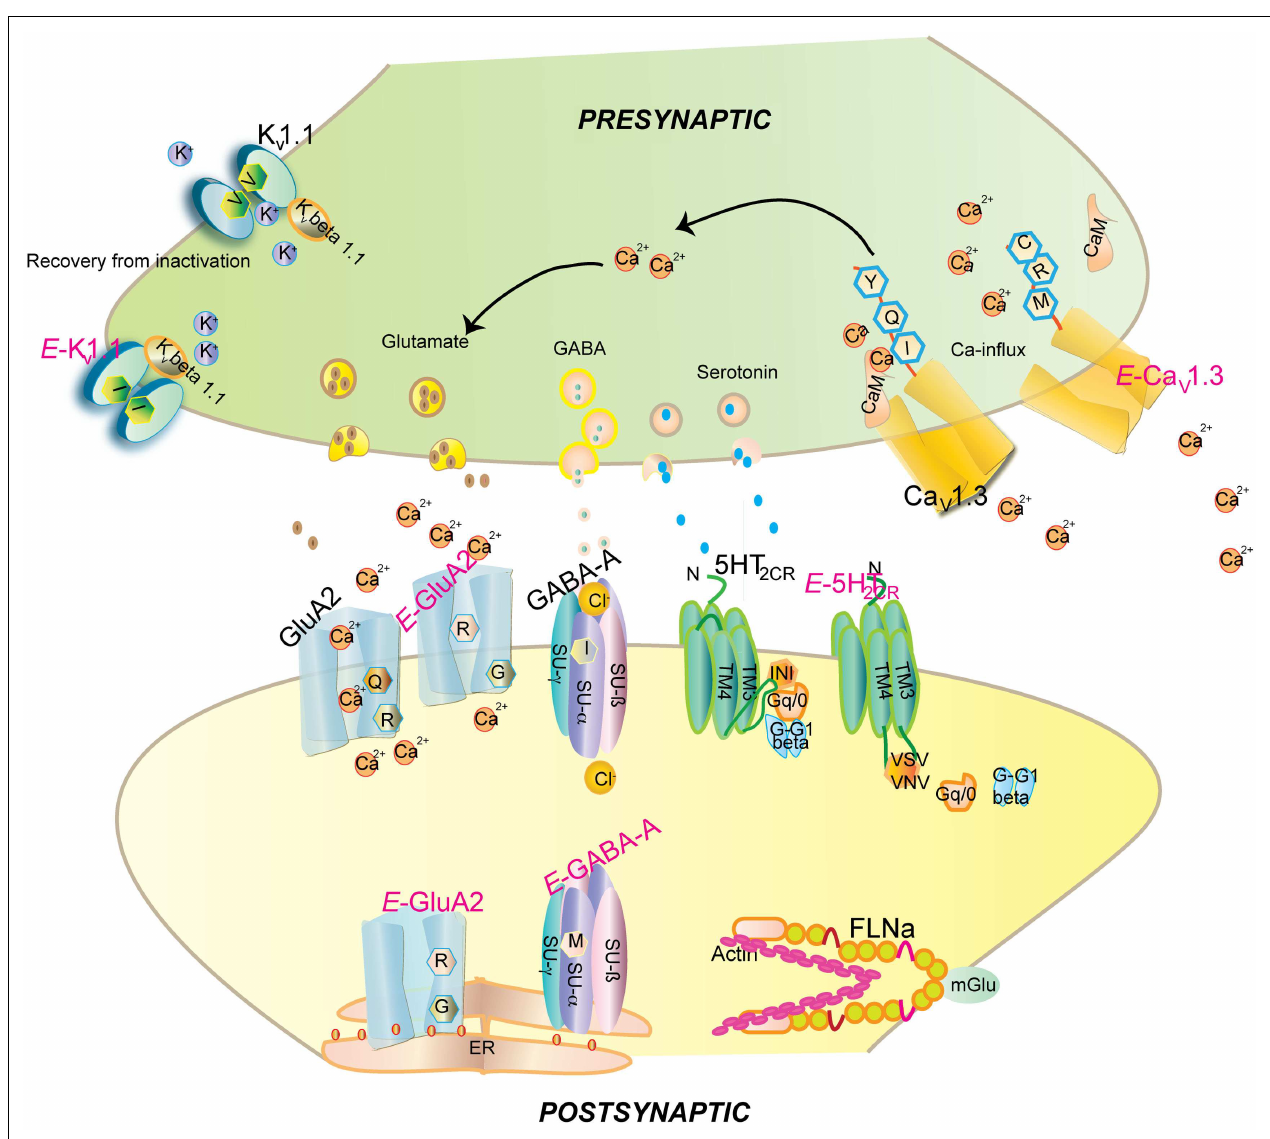
5-HT 2c receptor converts the amino acids I-N-I toV-S-V orV-N-V.This reduces G-protein coupling in the receptor.The editing-induced I toV exchange in K v 1.1 (I/V) alters the interaction with Kv β 1.1 (see Figure 3 for detail). Editing of the IQ motiv in Ca v 1.3 to MR abolishes calmodulin binding. Filamin alpha (FLNa)